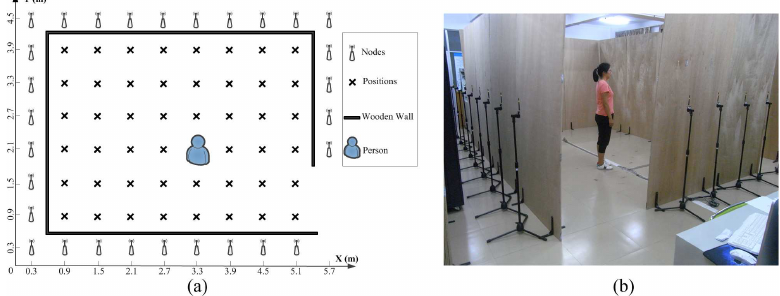
Figure 7. Experimental setup in indoor non-line-of-sight (NLOS) scenario. ( a ) Geography map; ( b ) prototype of the radio tomography networks.